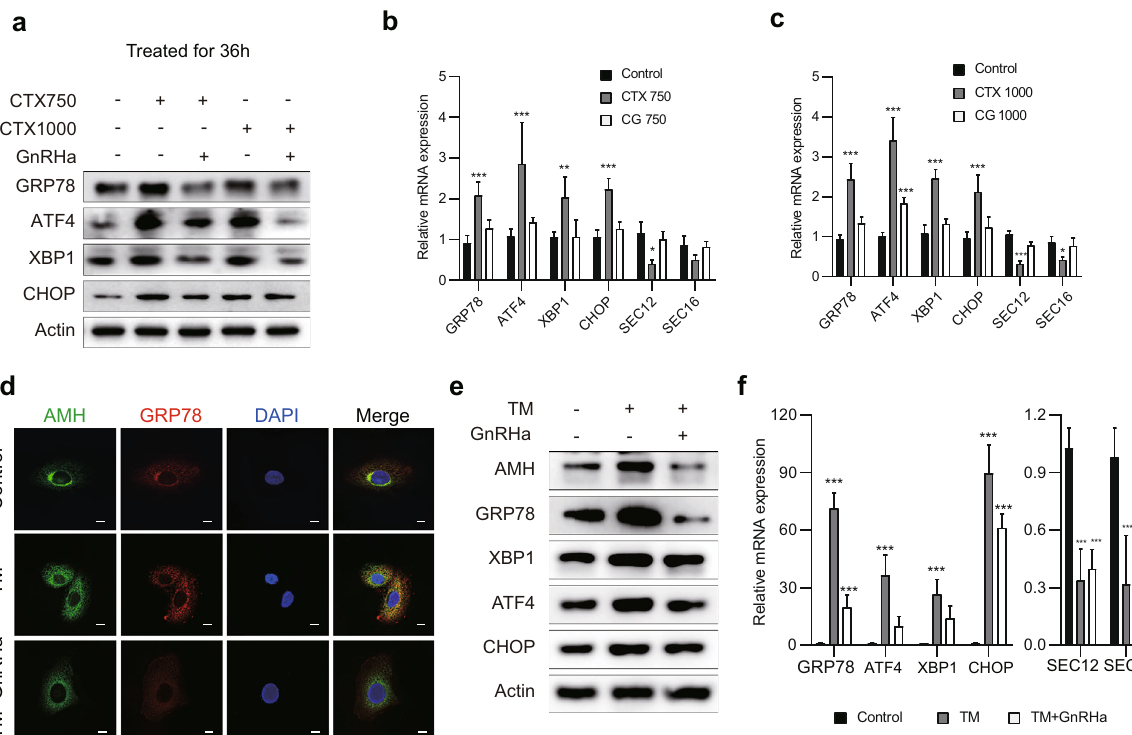
Fig. 5 GnRHa counteracts CTX-induced ER stress. a Expression of proteins including GRP78, ATF4, XBP1, and CHOP in the UPR pathway was assessed by western blotting. KGN cells were treated with 750 or 1000 µg/mL CTX, with or without GnRHa, for 36 h. b , c KGN cells were treated with CTX or CTX plus GnRHa for 36 h. mRNA levels were assessed by RT-qPCR for genes encoding proteins involved in the UPR ( GRP78 , XBP1 , ATF4, and CHOP ), and for genes encoding secretion-related proteins ( SEC12 and SEC16 ). Those mRNAs were upregulated by CTX and downregulated when co-treated with GnRHa. d Typical immuno fl uorescence staining indicated the localization of AMH within KGN cells. Yellow in the merged images indicates the colocalization of AMH and GRP78. Nuclei were stained with DAPI. Scale bars represent 100 µm. e TM was used for simulation of ER stress, and expressions of proteins in the UPR pathway were assessed by western blotting, the results were consistent with the CTX-treated cells. f TM-induced upregulation of UPR sensors was con fi rmed by RT-PCR for mRNA expression. One-way ANOVA was used for ( b , c , and f ), error bars show the standard error of the mean. * P < 0.05, ** P < 0.001, and *** P <